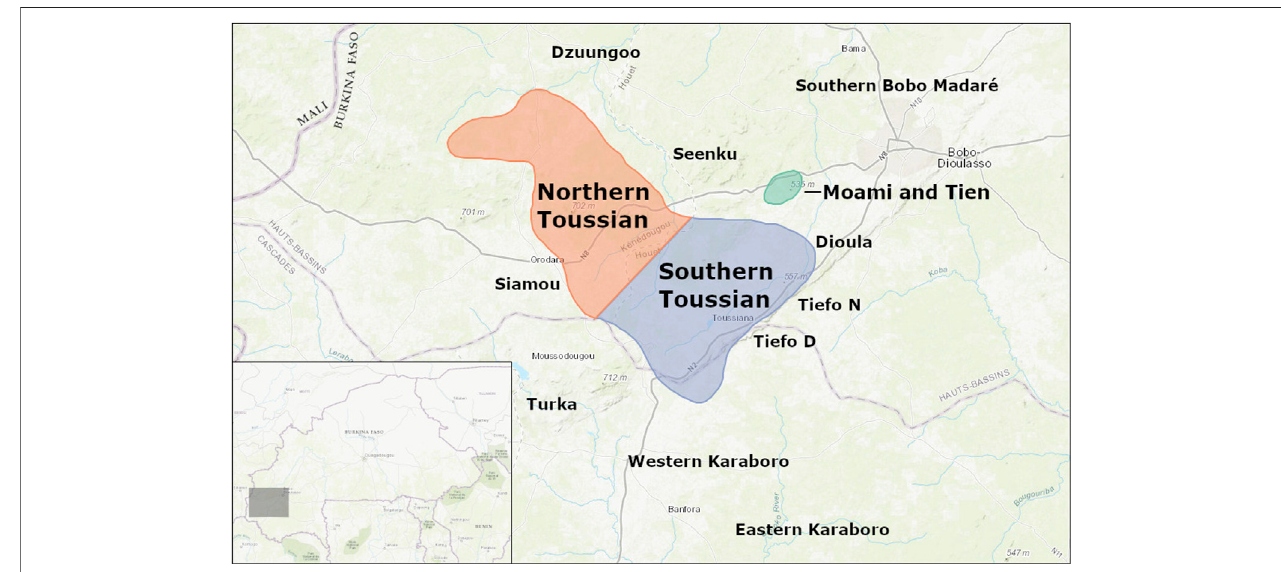
FIGURE 1 | Map of languages of southwest Burkina Faso.